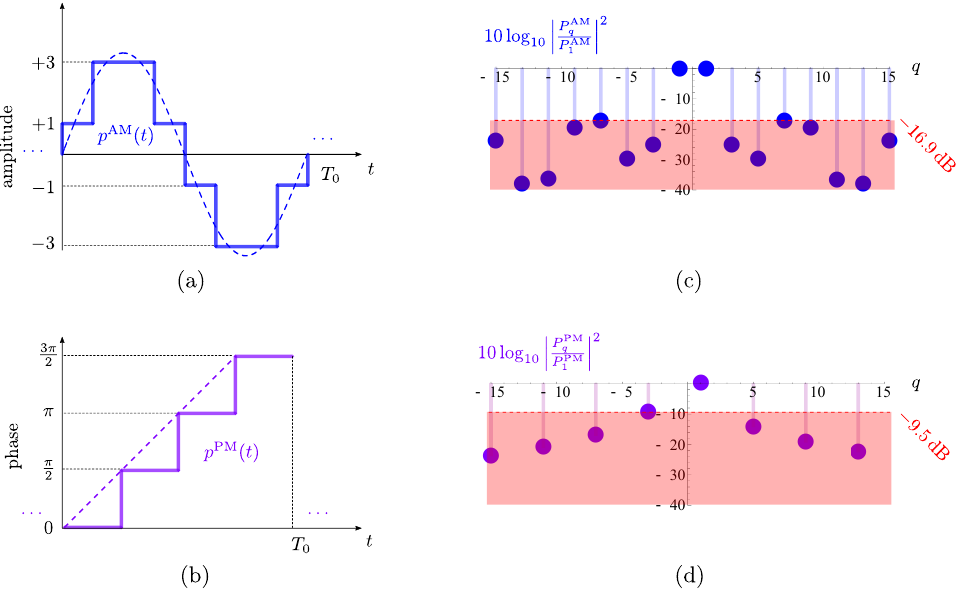
Figure 2. Four-level discretization of the waveforms shown in Figure 1: ( a ) discretized sinusoidal AM waveform (one period); ( b ) Discretized linear-phase PM waveform (one period). Normalized Fourier series power spectrum of the discretized waveforms: ( c ) AM waveform in ( a ); ( d ) PM waveform in ( b